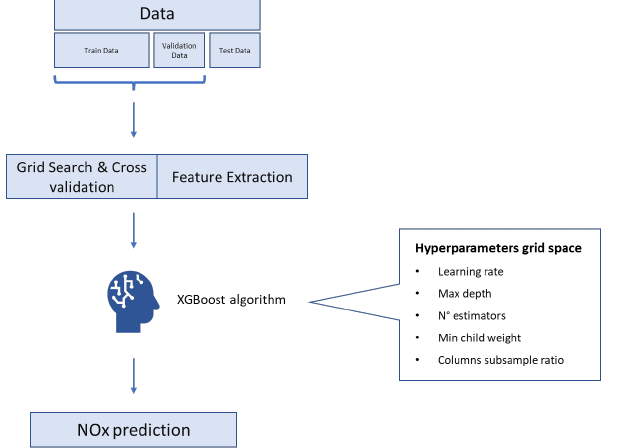
Figure 3. The workflow of XGBoost learning process. The involved Hperparameters in the XG- Boost model are the following: the n _ estimators , which specifies the number of decision trees to be boosted; the max _ depth , which limits the depth in each tree’s growth; the Learning _ rate , which is a regularization parameter that shrinks feature weights in each boosting step; the min _ child _ weight , which corresponds to the minimum number of instances needed to be in each node of the tree; the columns _ subsample _ ratio , which is the subsample ratio of columns when constructing each tree